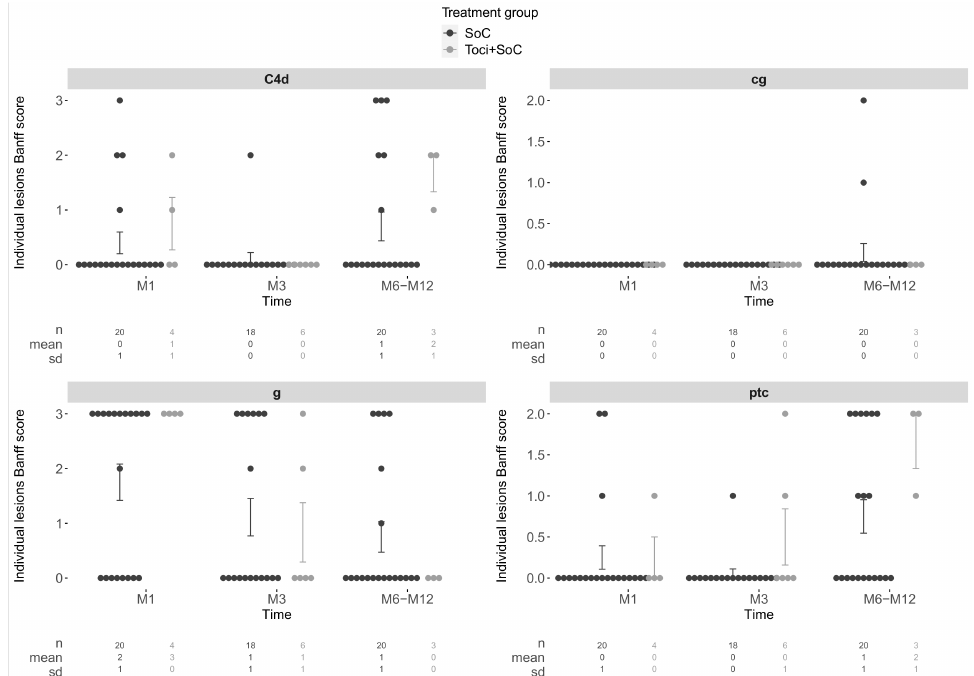
Figure 6. Individual Banff score items (C4d, cg, g, and ptc) over time for all systematic biopsies performed at M1 and M3 and between M6 and M12 post-transplantation. The two treatment groups are represented in black (SoC group, 26 patients) and grey (Toci + Soc group, 7 patients). Mean and standard-error bars are